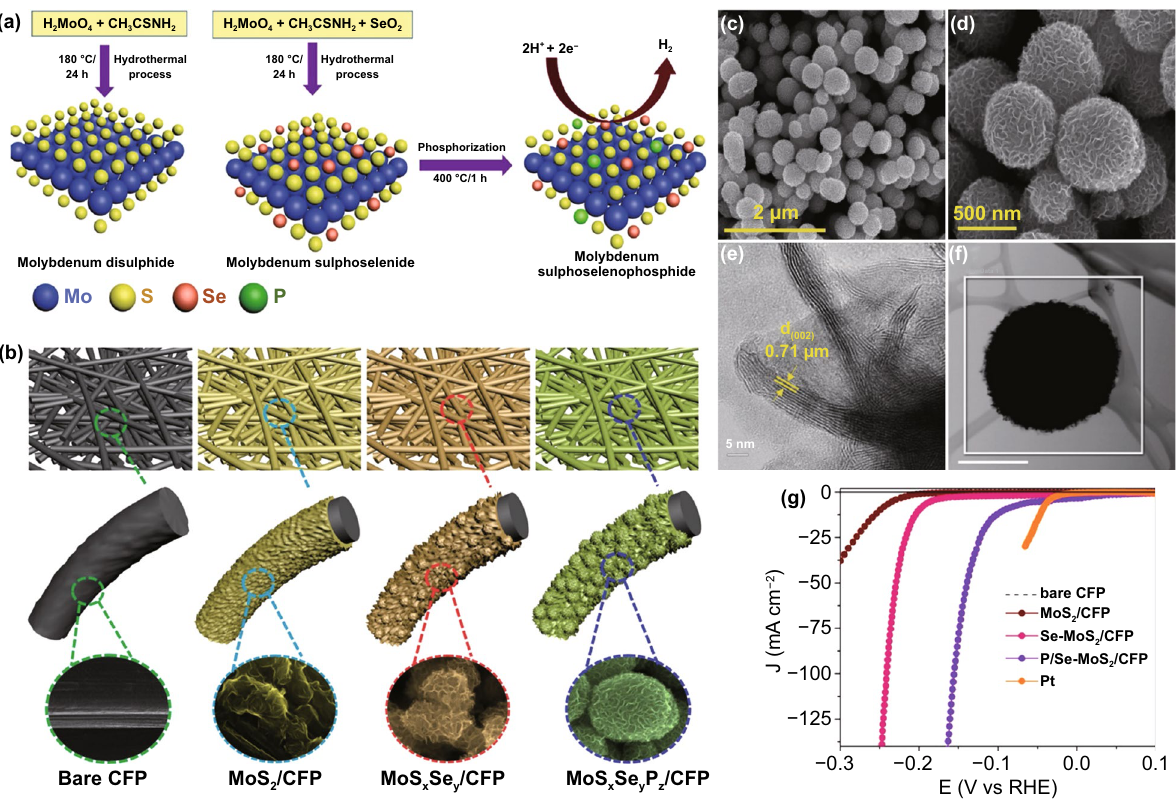
Fig. 11 a Schematic illustration of the fabrication of the MoS 2 , MoS x Se y , and MoS x Se y P z on CFP by facile hydrothermal and phosphorization process. b Schematic diagram to illustrate the structural change of CFP, MoS 2 , MoS x Se y , and MoS x Se y P z based on anion incorporation. c–f FESEM (P/Se–MoS 2 spheroids distributed on CFP), HRTEM and STEM images of P/Se–MoS 2 g Polarization curves of as-prepared various catalysts in comparison with commercial Pt and bare CFP. Reprinted with permission from Ref. [158]. Copyright Year 2018, Wiley–VCH Ver- lag GmbH & Co. KGaA,